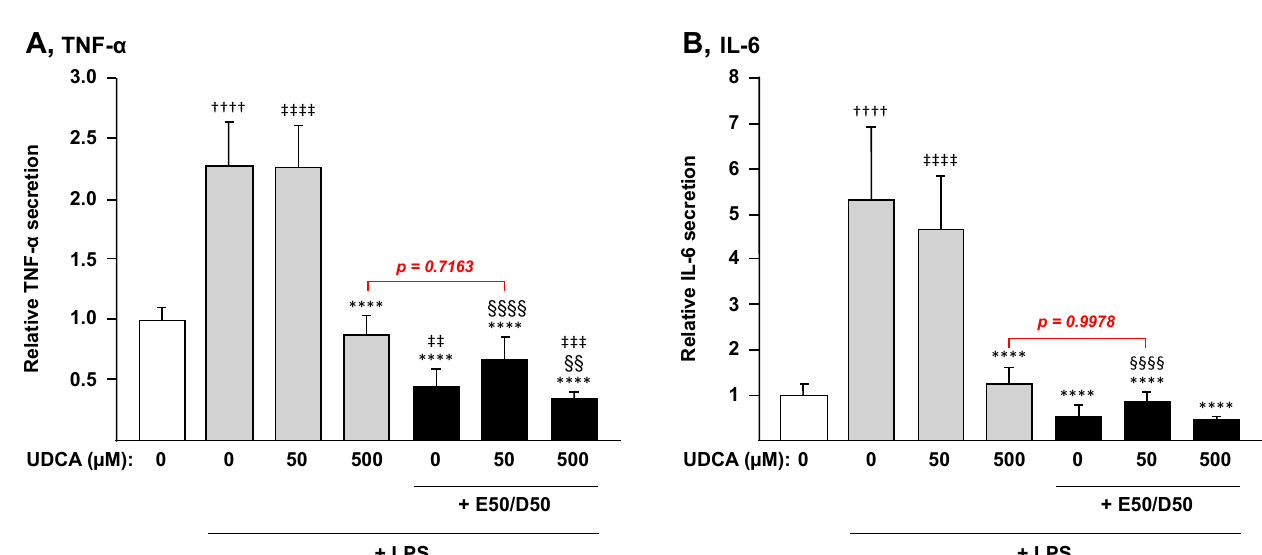
Figure 5. N-3 PUFAs block LPS-induced secretion of cytokines by macrophages. THP-1 monocytes were differentiated into macrophages with PMA for 72 h and then stimulated with 100 ng/ µ L LPS for 24 h in the presence or absence of EPA/DHA, UDCA or their combination. The level of IL-6 and TNF- α cytokines in culture media was measured by ELISA as described in the materials and methods section. Cytokine levels are expressed relatively to control cells set at 1. Data represent the mean of two independent experiments in which each treatment was performed in triplicate. Each data point therefore corresponds to the mean of 6 replicates ± SD. Statistical significances as determined by a one-way ANOVA followed by Tukey’s multiple comparison post-hoc were as follows: Untreated differentiated THP-1 exposed to vehicle vs. untreated differentiated THP-1 exposed to LPS: †††† p < 0.0001; Vehicle differentiated THP-1 vs. UDCA treated differentiated THP-1: ‡‡ p < 0.01; ‡‡‡ p < 0.001; ‡‡‡‡ p < 0.0001; LPS exposed differentiated THP-1 vs. LPS + UDCA ± EPA/DHA exposed differentiated THP-1: **** p < 0.0001; UDCA treated differentiated THP-1 vs. UDCA + EPA/DHA treated